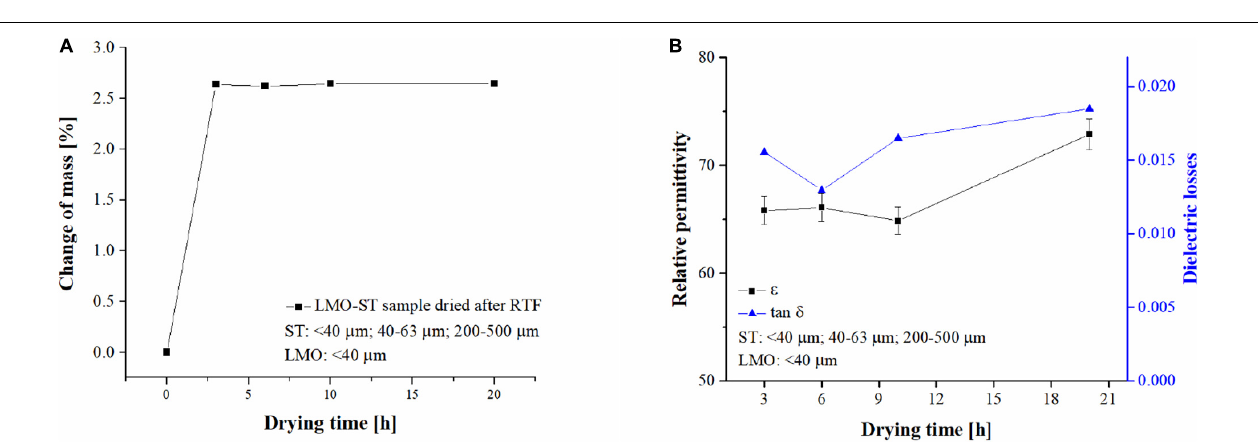
Frontiers in Materials |